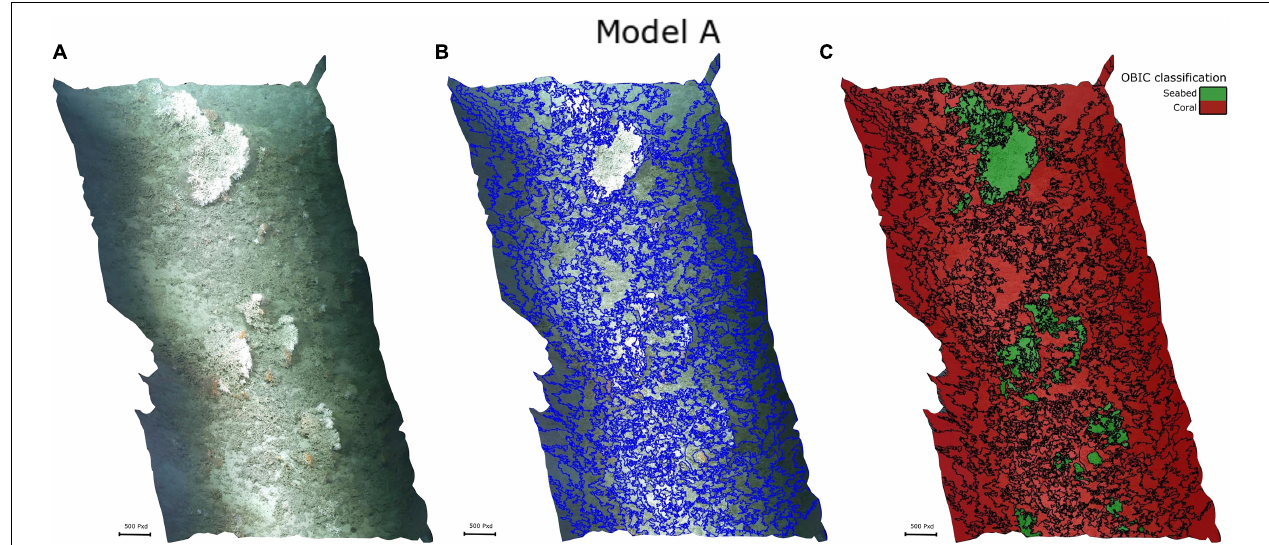
FIGURE 9 | Results of classification using OBIA method— (A) Orthomosaic, (B) output of the multi-resolution automated segmentation, and (C) manual classification.